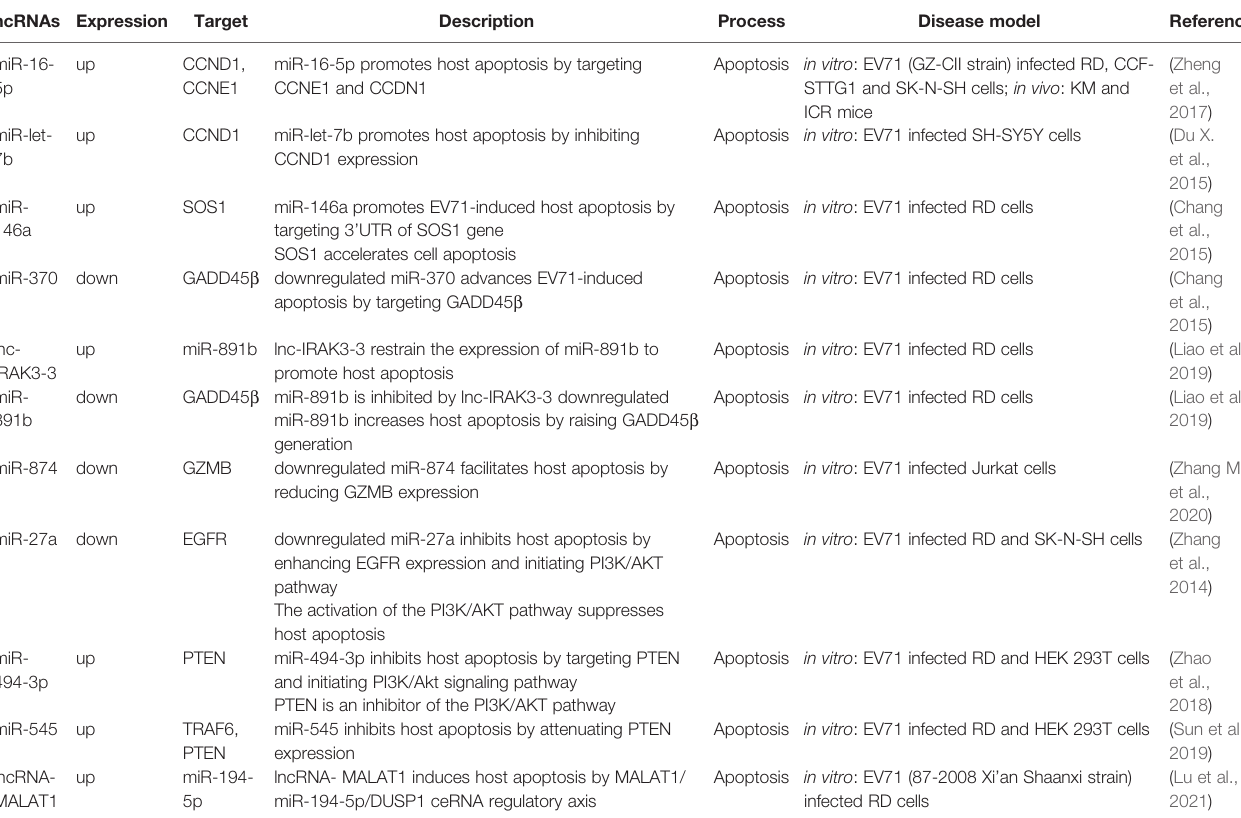
TABLE 2 | ncRNAs involved in host